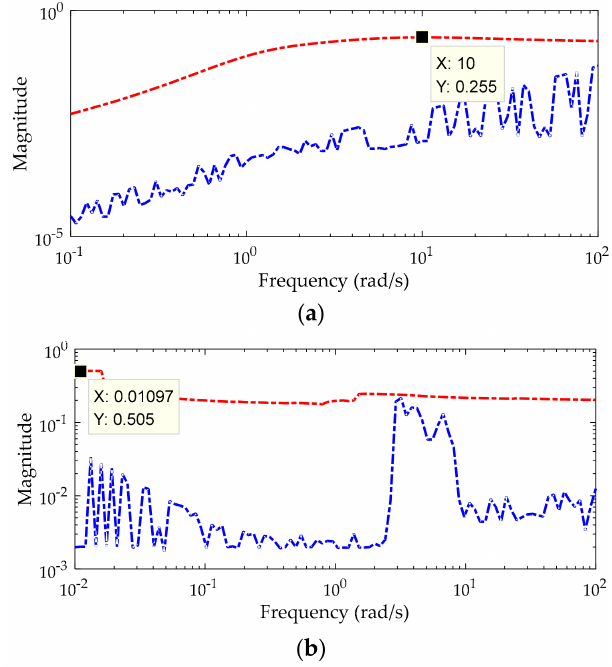
Figure 6. The index of robust stability and robust performance, ( a ) the robust stability of controller, upper bound (red) and lower bound (blue); ( b ) the robust performance of perturbed system, upper bound (red) and lower bound (blue).